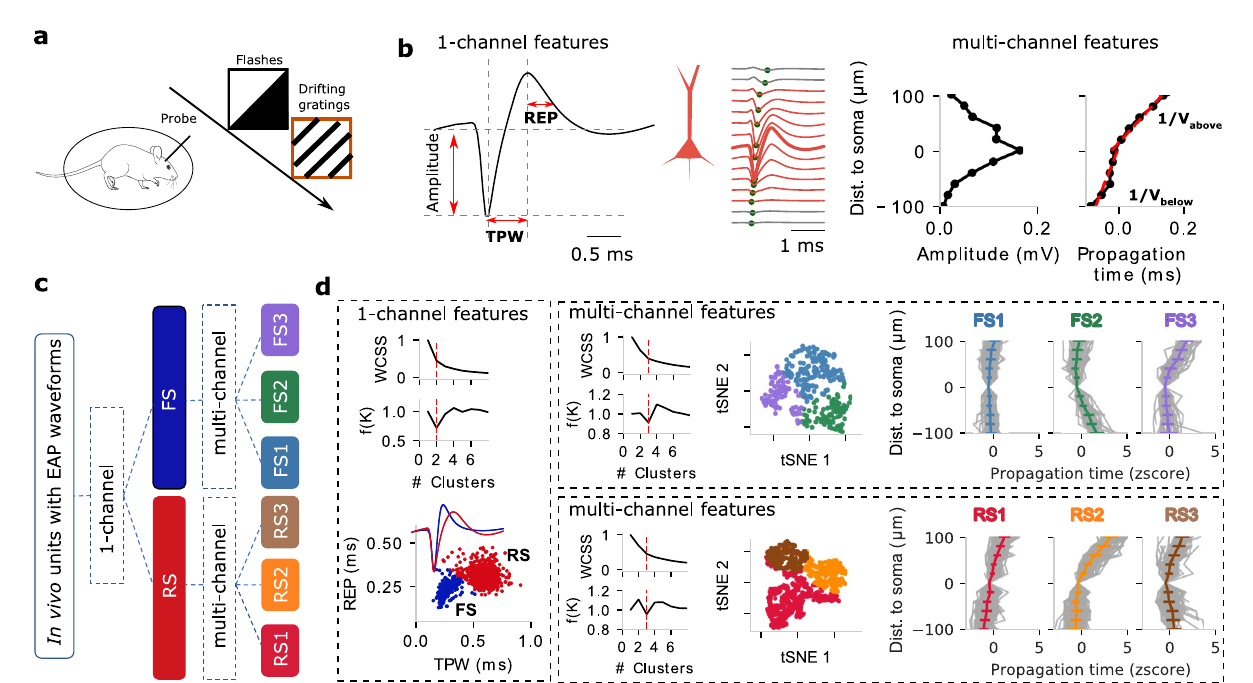
Fig.2|ClusteringofinvivoV1unitsfromwild-typemicebasedonextracellular action potential (EAP) features during drifting gratings results in two one- channel and six multi-channel clusters with distinct EAP properties. a Animals are exposed to visualstimuli(e.g., fl ashes and drifting gratings) while running on a wheel with Neuropixels probes recording extracellular V1 activity. b One-channel EAP waveform features (left) from the location of the largest EAP amplitude: trough-peak width (TPW) and repolarization time (REP). Multi-channel EAP wave- form features: the inverse of propagation velocity below (1/ V below ) and above (1/ V above ) soma are separately estimated by linear regression (right, red lines). c Unsupervised clustering on one-channel EAP features (TPW and REP) results in two major populations, fast-spiking (FS) and regular-spiking (RS) units.